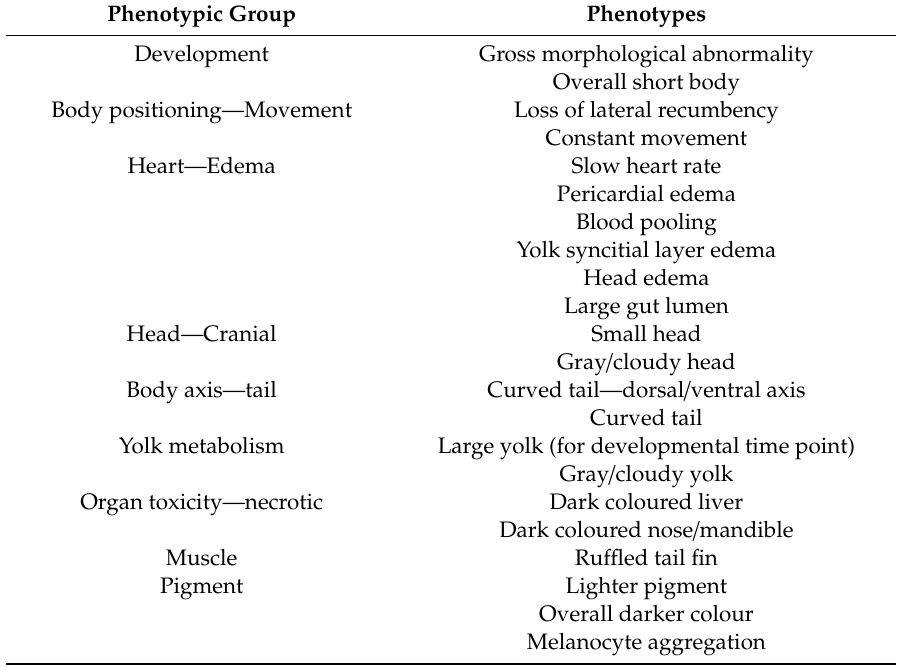
Table 2. Phenotypes and phenotypic groupings used for manual scoring of larvae at 120 h post fertilization (hpf) for both the Zebrafish Embryo Toxicity (ZET) and General and Behavioral Toxicity (GBT) assays.